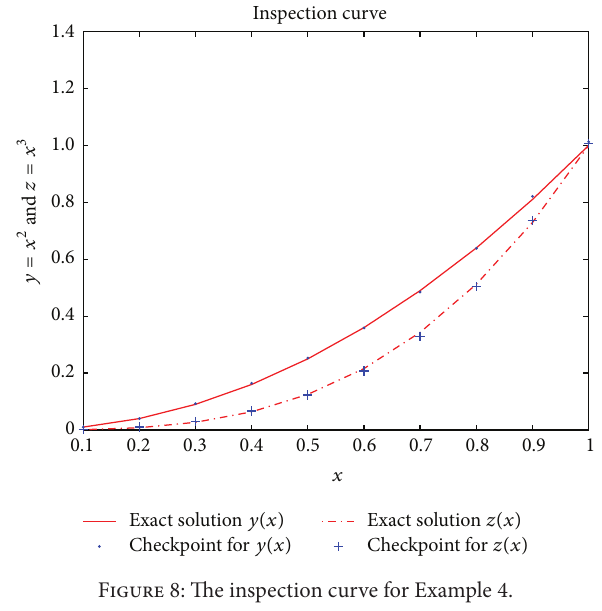
Figure 8: The inspection curve for Example 4.